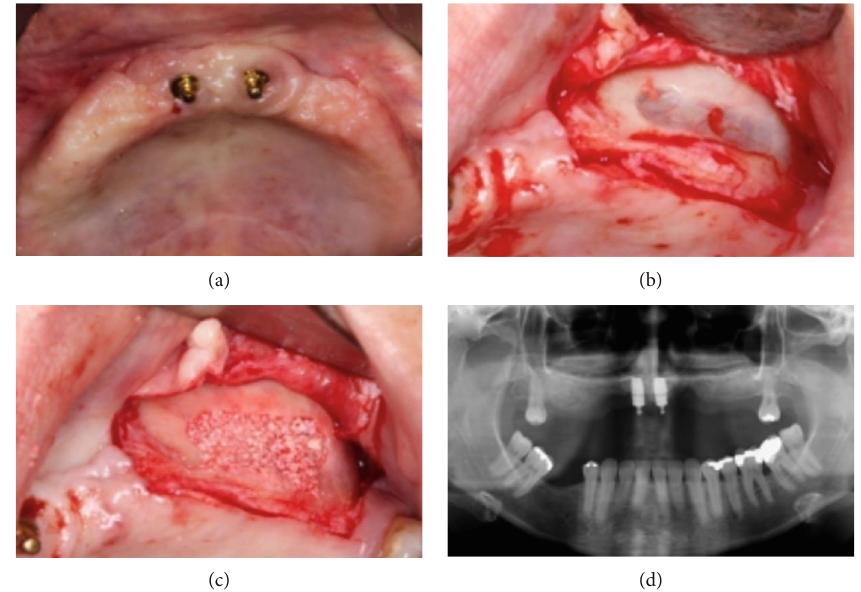
Figure 5: The second surgical procedure was carried out to augment the maxillary sinuses. DBBM plus L-PRF was used to fi ll the sinuses aiming at increasing bone height to allow proper implant length installation (a – c). Panoramic radiography shows the maxillary sinuses immediately after bone graft